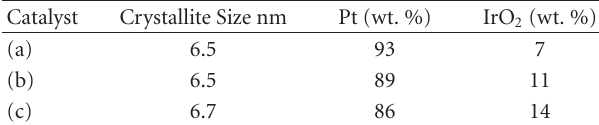
Table 1: Composition and crystallite size of the catalysts.